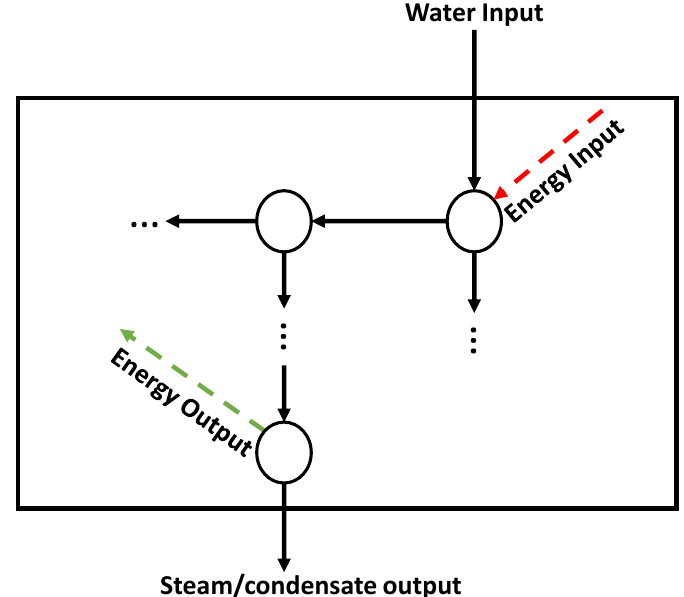
Figure 6. Schematic of the balancing nodes and